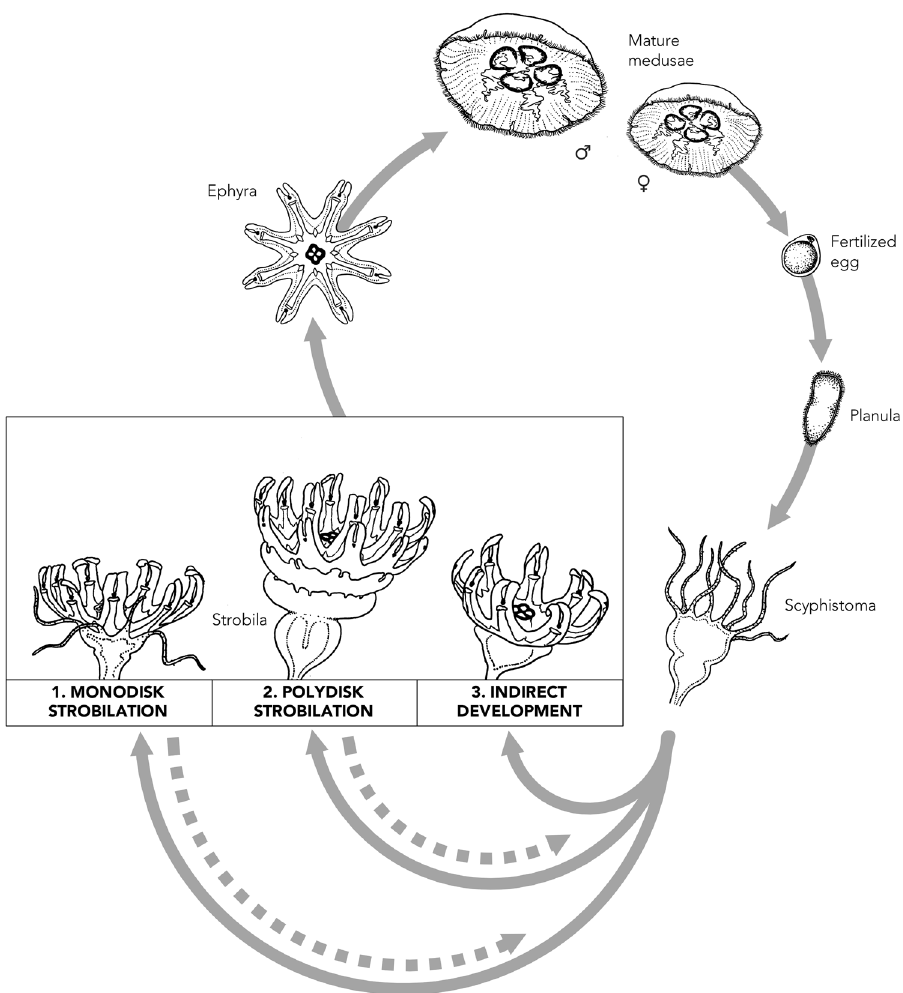
Figure 3. Revised life cycle of Aurelia sp. with the addition of the indirect development as a reproductive strategy to produce ephyrae in addition to mono- and polydisk strobilations (drawing by Louise